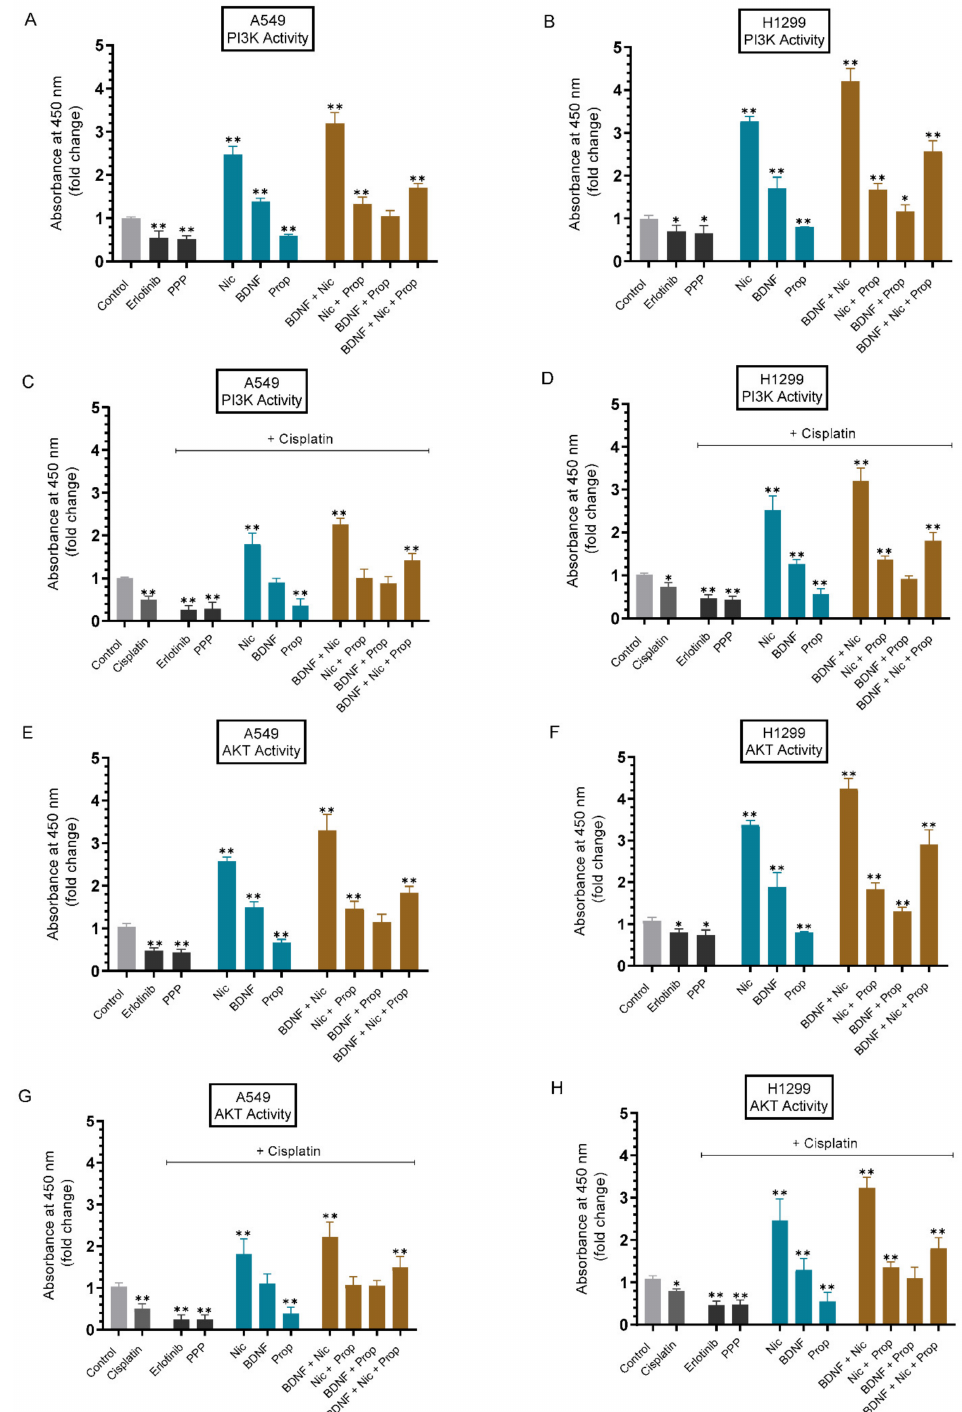
(Figure 5). Co-treatment of either A549 or H1299 cells with BDNF and nicotine led to a greater increase in the PI3K and AKT activities, compared to treatment with either BDNF or nicotine alone. This increased kinase activation was blocked by cell incubation with BDNF, nicotine, and propranolol (Figure 5). In the presence of cisplatin, the values for the PI3K (Figure 5C,D) and AKT (Figure 5G,H) activities were lower with the same treatments, but had a comparable trend as that observed in the absence of cisplatin.